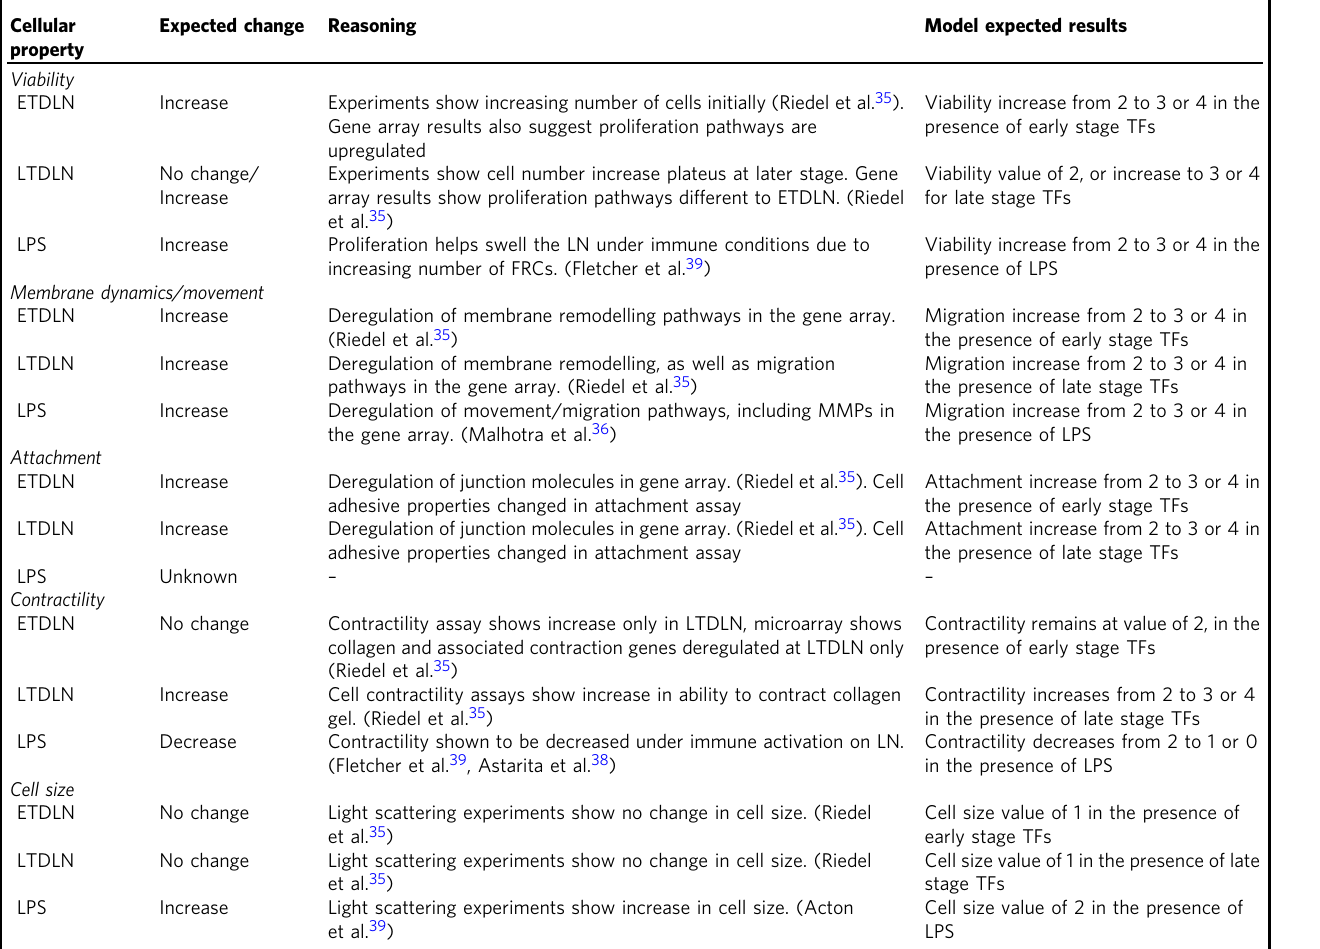
Table 3 Phenotype expression speci fi cation generated from gene arrays from FRCs Cellular